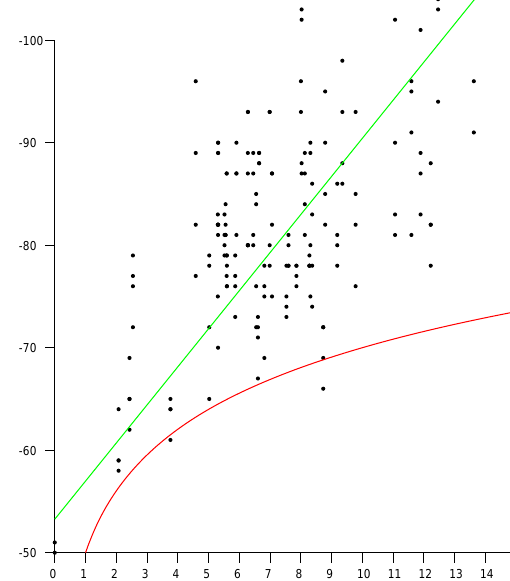
Figure 1. Scattergram of Signal Strength (RSS) versus distance in typical three-level wooden building. Horizontal axis: distance between smartphone and Wi-Fi access points (APs) (in meters). Vertical axis: Signal Strength (in dBm). Red curve: expected inverse square law dependence ( − 50 − 20 log ( R ) dBm). Green line: linear fit ( − 53 − 3.7 R dBm). Because of the large scatter, it should be clear that RSS is not very useful for estimating